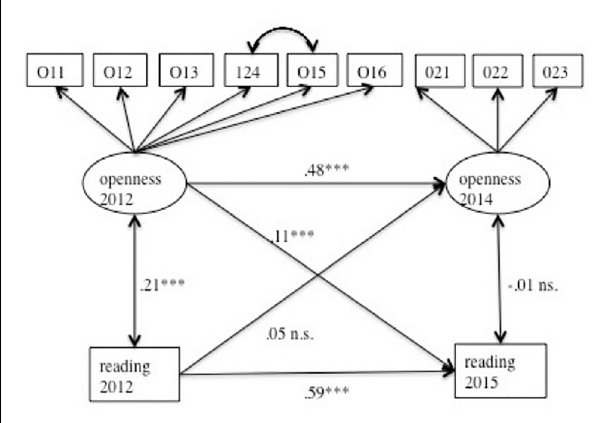
FIGURE 1 | Cross-lagged model for Openness and reading books. Openness and reading books were measured two times each. The model includes autoregressive paths, the correlation path between openness and reading at the same measurement occasion, and cross-lagged paths between Openness and reading at different time points. Openness is a latent variable (loadings on the indicators were left out) and reading a manifest variable. O11–O16, indicators of Openness at the first measurement occasion (see also Table 1 ), O21–O23, indicators of Openness at the second measurement occasion. ∗∗∗ p <